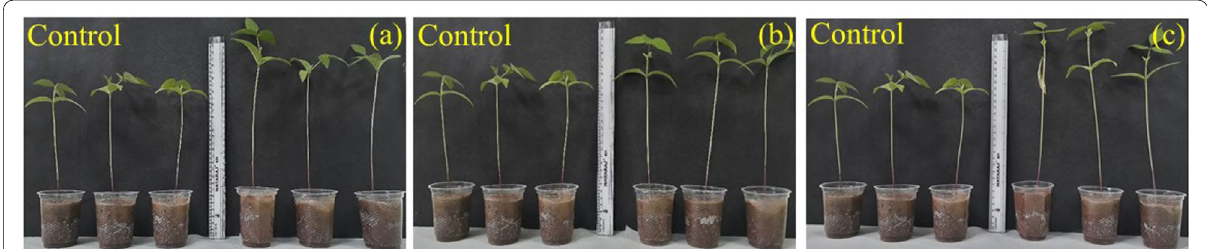
Fig. 5 Effect of application of recovered TMAOH [obtained from a animal wool, b chicken feather, and c human hair processing] and water mixture (1:1) for seed treatment on shoot length of green gram after 15 d of